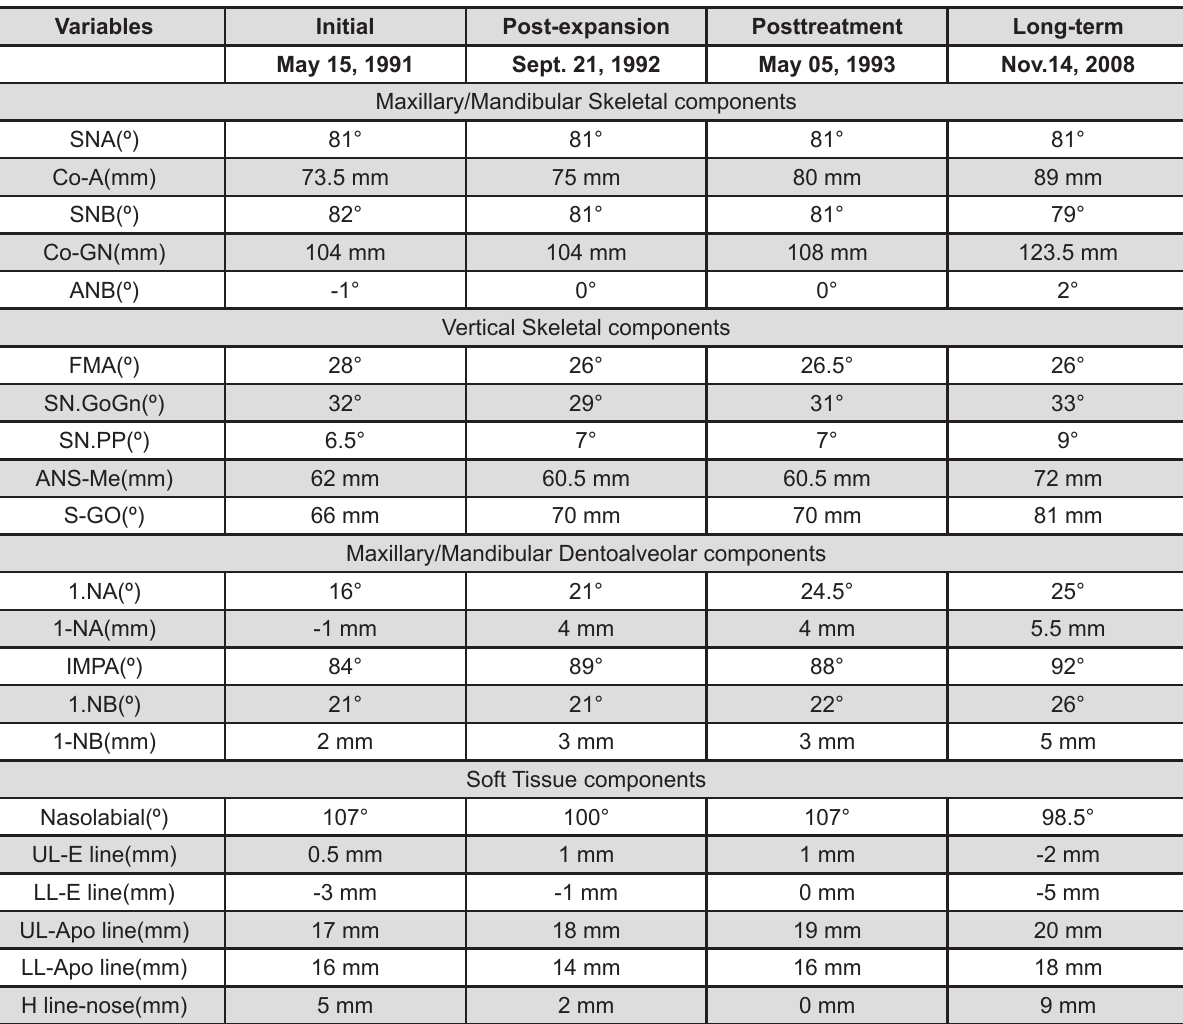
Figure 10- Cephalometric analysis measurement of 73.5 mm, and Co-Gn 104